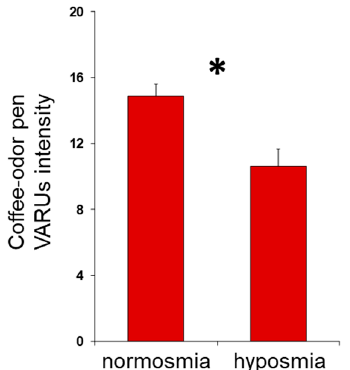
Figure 5. Mean ( ± SEM) values of the intensity perceived for the coffee-odor pen by subjects, according to their TDI olfactory status. Asterisk indicates significant differences between individuals with normosmia or hyposmia ( p < 0.005; Fisher’s LSD test subsequent to one-way ANOVA).